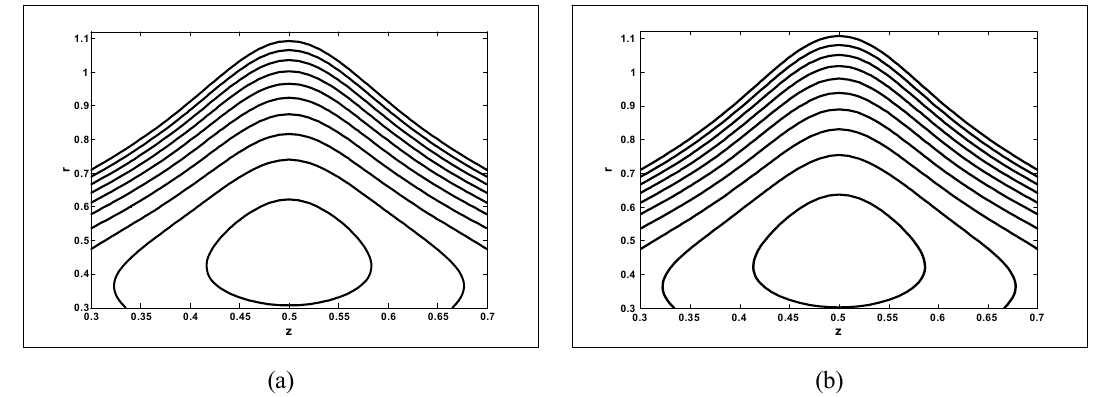
Figure 14. Streamlines for two di ff erent values of ϕ for ( a ) ϕ = 0.1 and ( b ) ϕ = 0.101. The other parameters are chosen as M = 2, Q = 0.41, r 1 = 0.65 when µ =